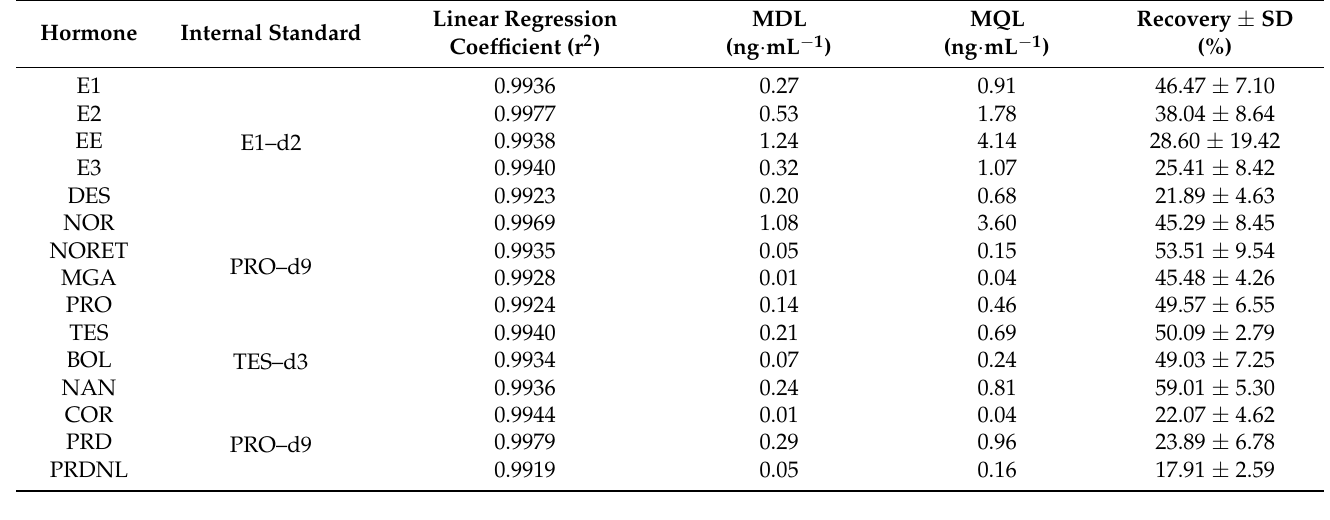
Table 4. Analytical parameters for the target steroid hormones.